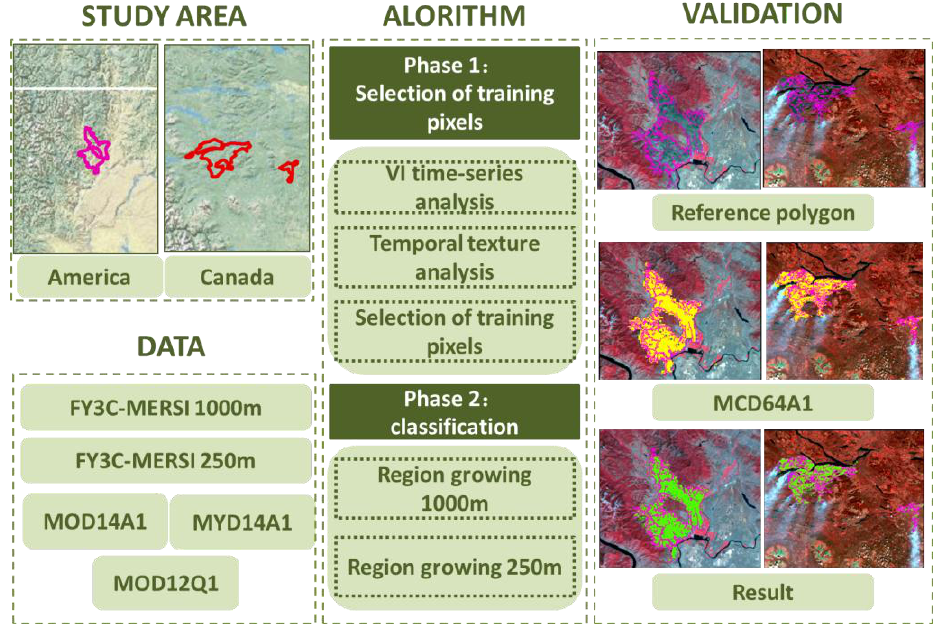
Figure 1. Graphical Abstract.